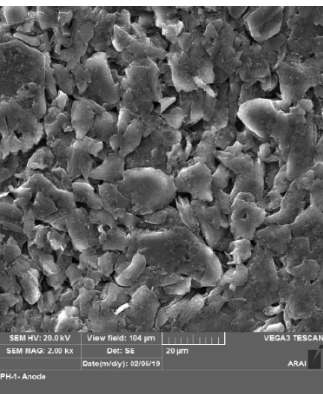
Figure 4. New cell cathode.